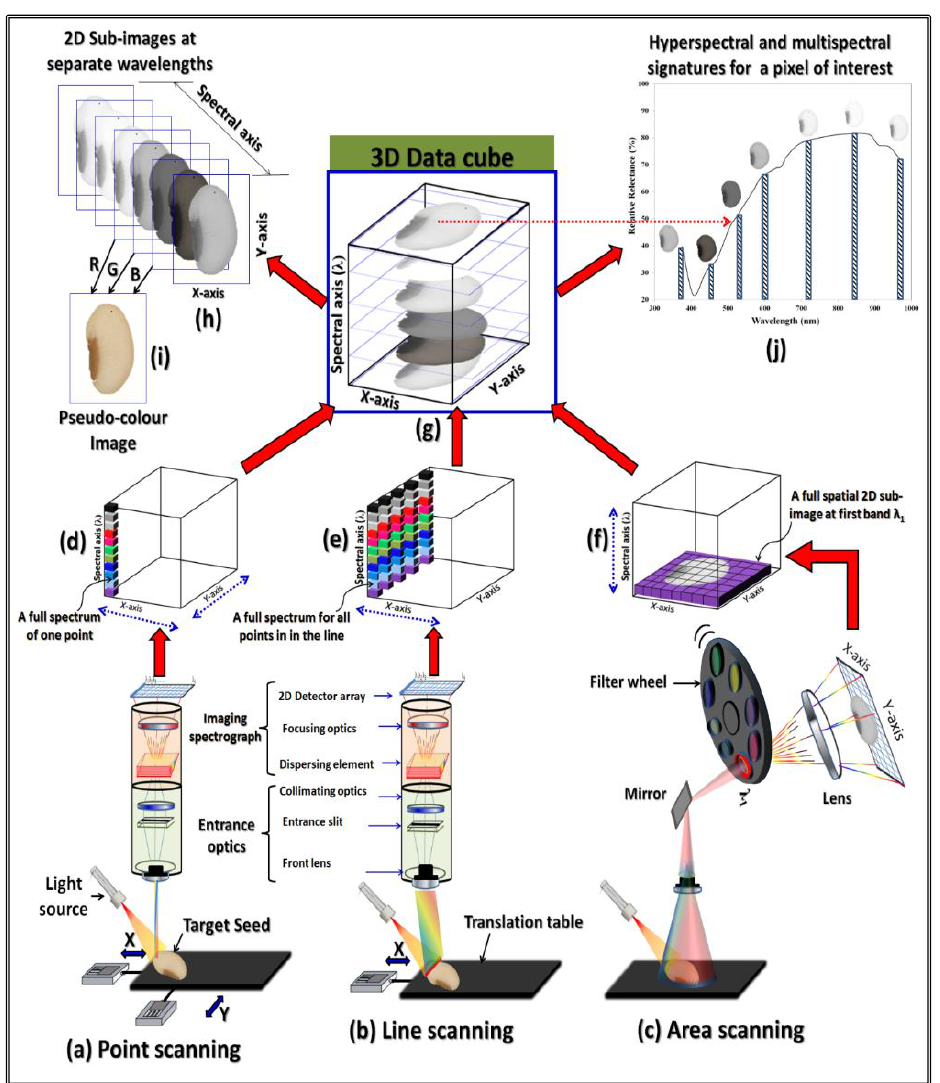
Figure 2. Schematic representation of three approaches used for constructing spectral image cubes. The blue dashed arrows indicate scanning directions in each approach for sequential acquisitions to complete the volume of spatial and spectral 3D data cube.